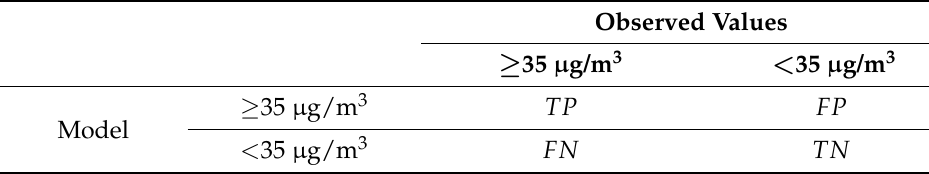
Table 2. Contingecy table for the daily exceedances of the threshold of 35 µ g/m 3